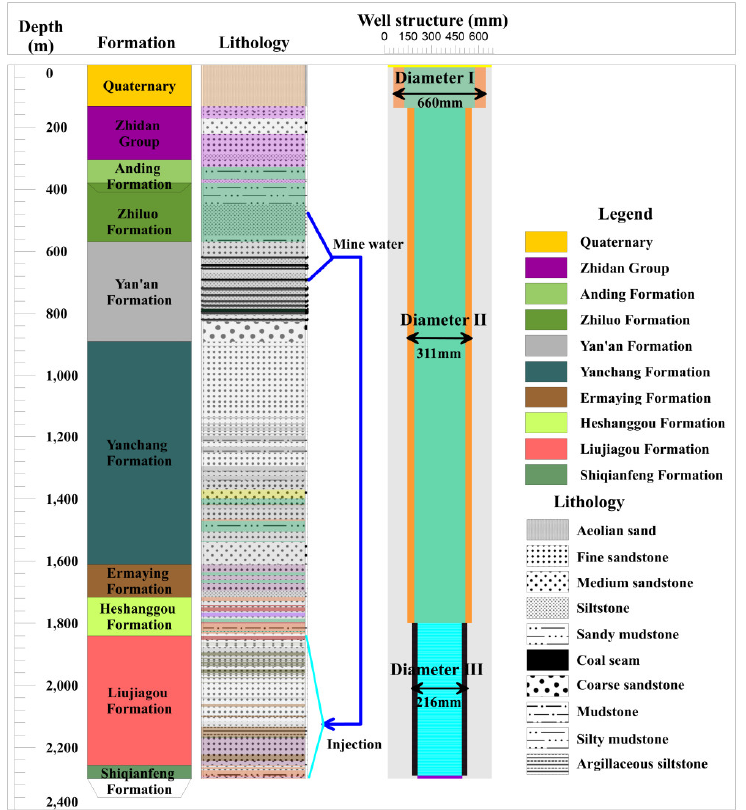
Figure 2. Ordos Basin hydrostratigraphy with mine water injection well structure. Mine water from the coal measure strata named Yan’an Formation is injected into Liujiagou Formation. Different lithology with colors is showed.